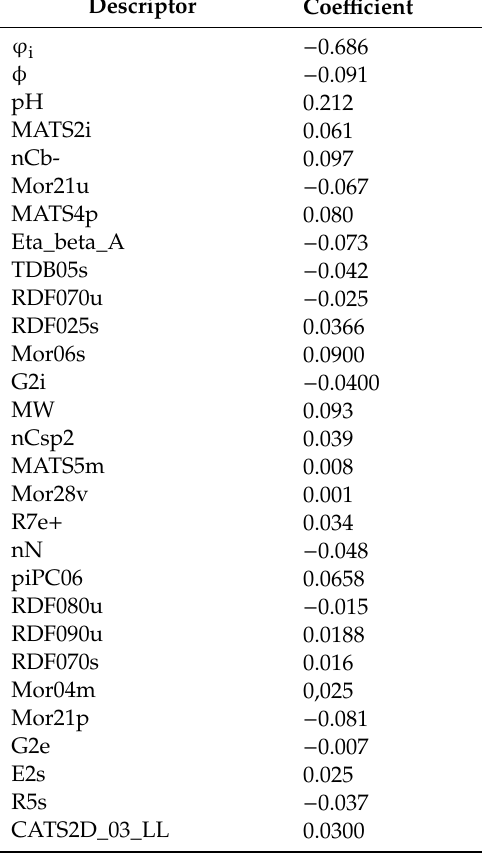
Table A3. Regression coe ffi cients extracted from the PLS model based on the 29 descriptors selected by